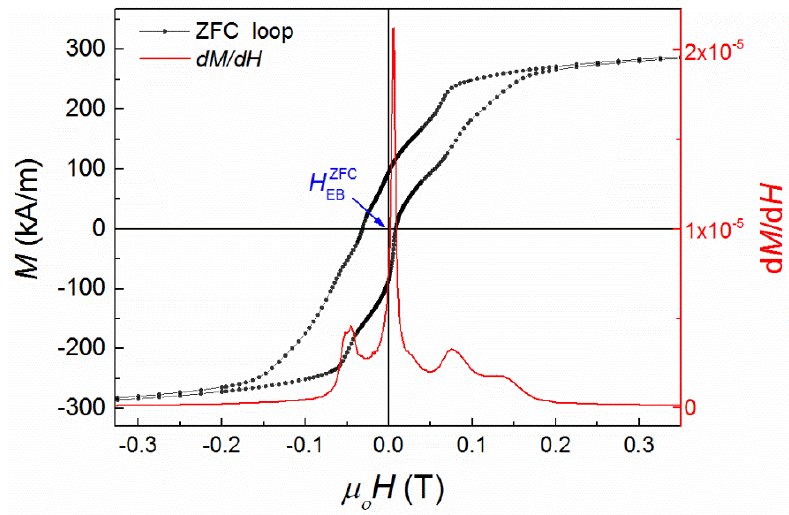
Figure 2. Zero-field cooling (ZFC) loop (black curve) at 5 K, after quenching the superconducting magnet, and the derivative of the magnetization as a function of the applied field calculated in the second half of the loop (−2 T to 2 T; red curve).